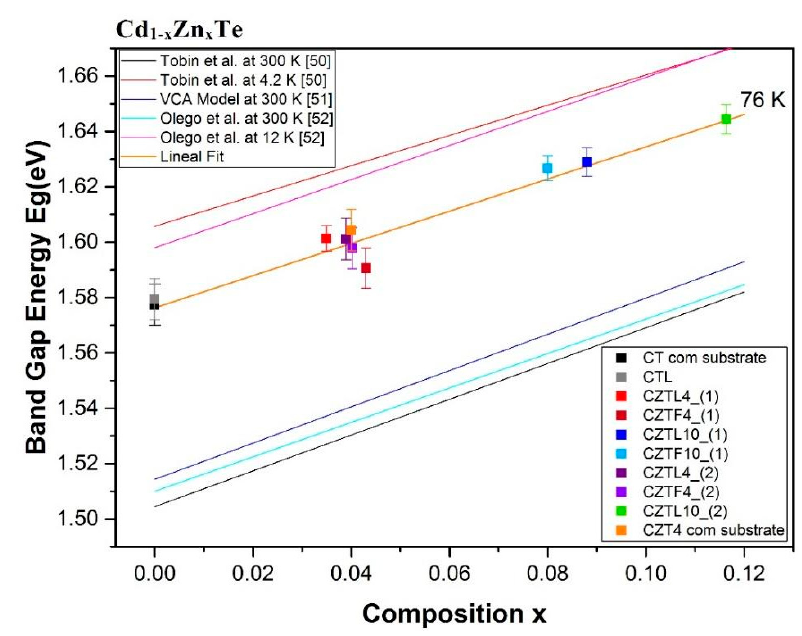
Figure 12. Eg as a function of the Zn atomic fraction in the concentration range of 0 ≤ x ≤ 0.10. The points, obtained in this work, are compared with some models from the literature (lines).